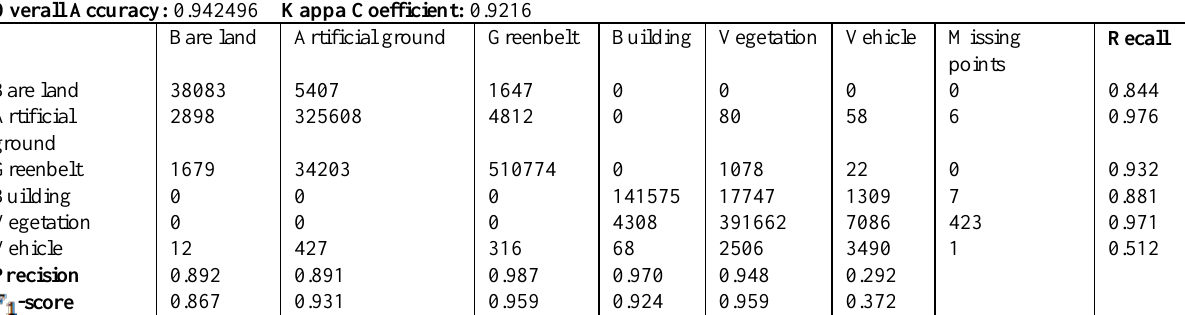
Table 1. The confusion matrix, and accuracies of the classification result. Overall Accuracy: 0.942496 Kappa Coefficient: